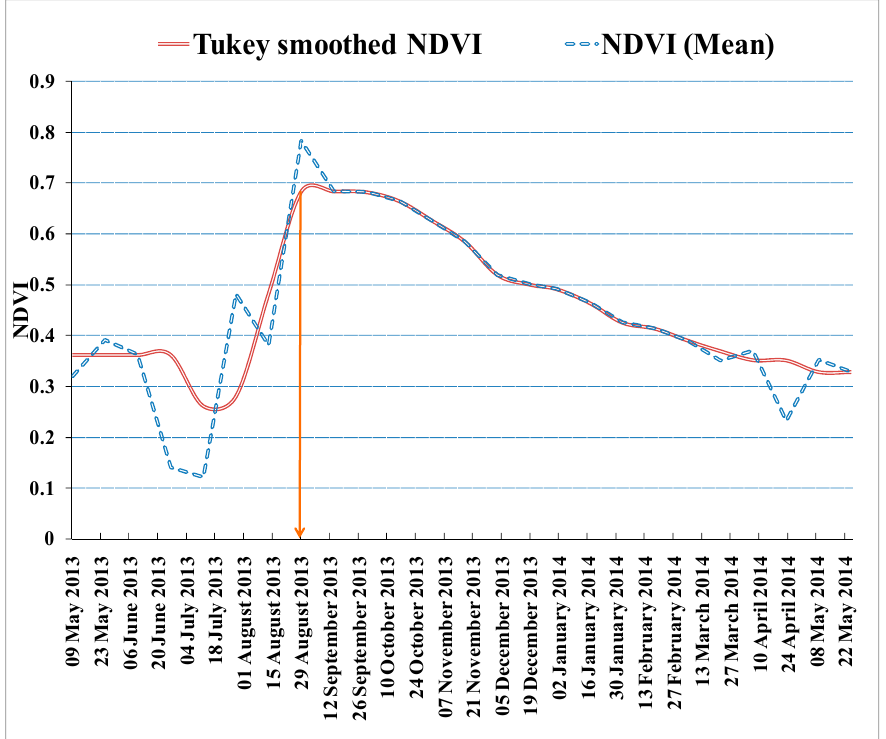
Figure 11. Raw MODIS NDVI and TS-smoothed reconstructed NDVI time series of year 2013–2014 for derivation of maximum of the season in Tectona grandis indicated by orange arrow.